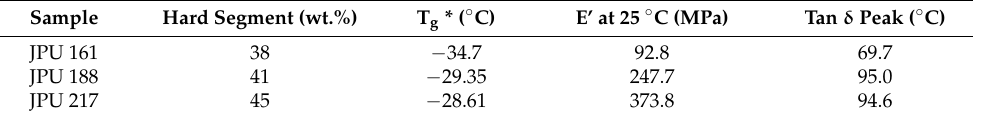
Table 6. Glass transition temperature and dynamic mechanical properties of JPU